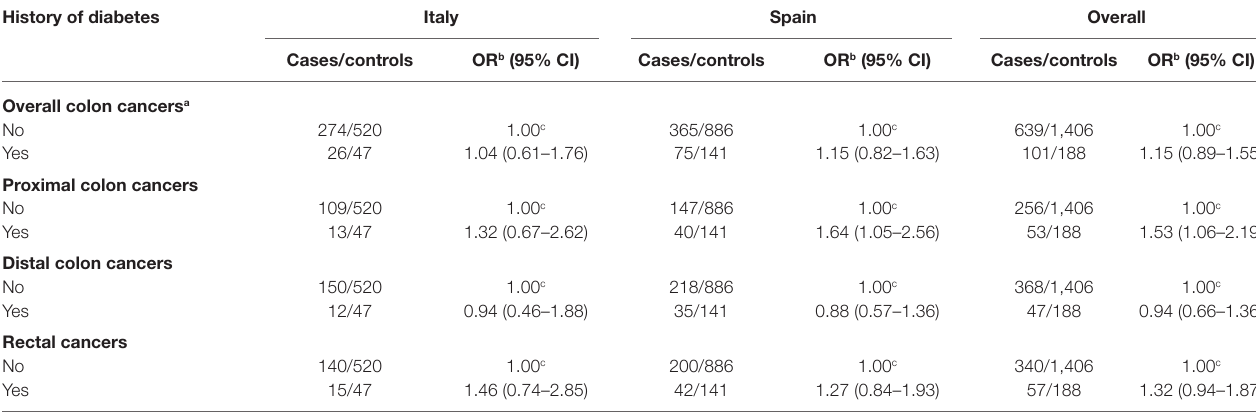
TaBle 3 | Distribution of anatomical subsites of colorectal cancer a cases and corresponding controls, with odds ratios (Ors) and 95% confidence intervals (cis), according to history of diabetes by country and overall. history of diabetes italy